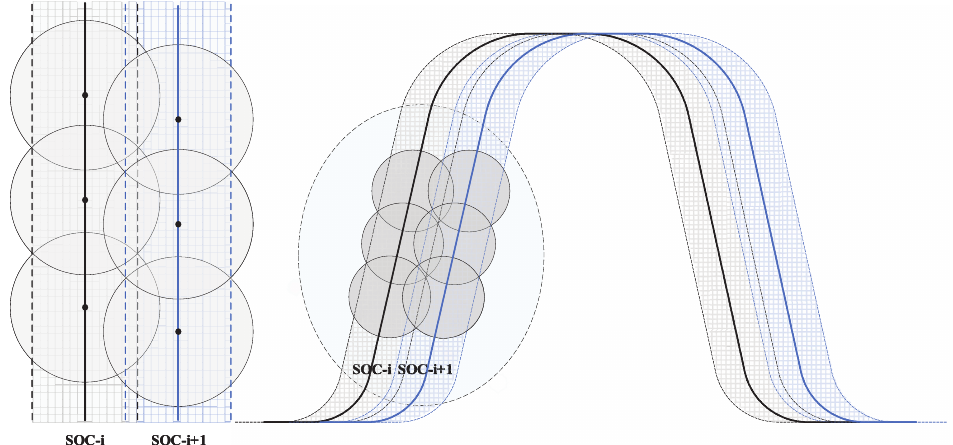
Figure 3. Streets-of-coverage geometries of adjacent orbital planes. To sum up, the continuous coverage constraint of the mega constellation is defined as follows: The continuous coverage can be guaranteed for a designed latitude range if